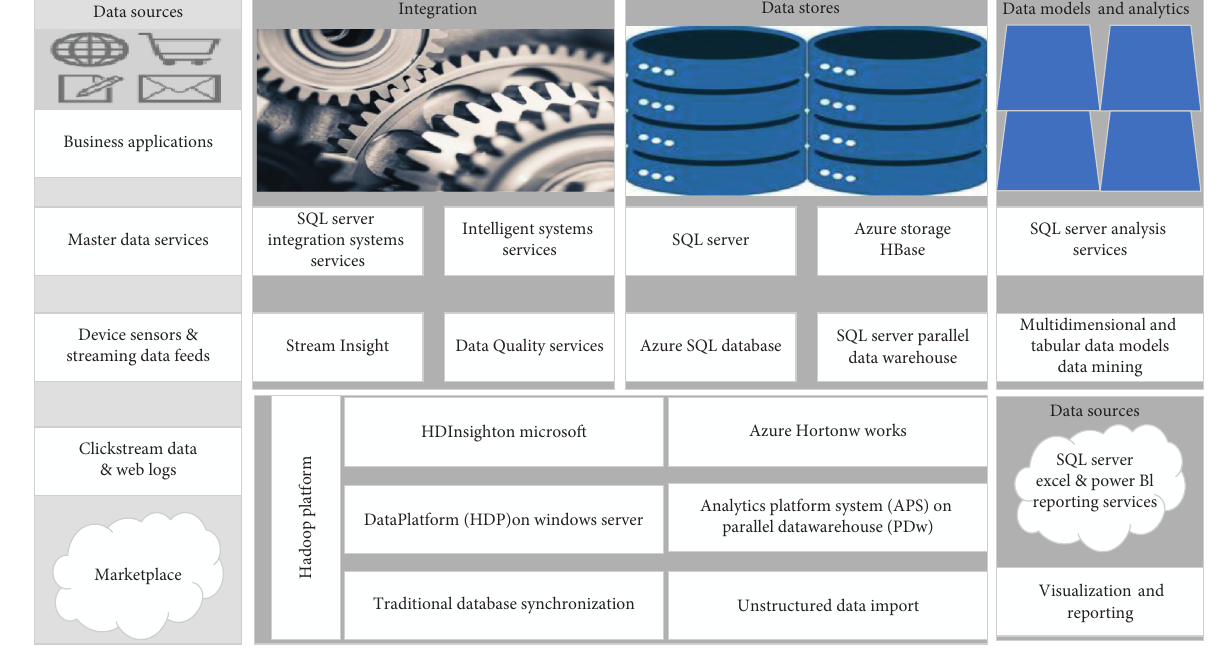
Figure 1: Big data technology